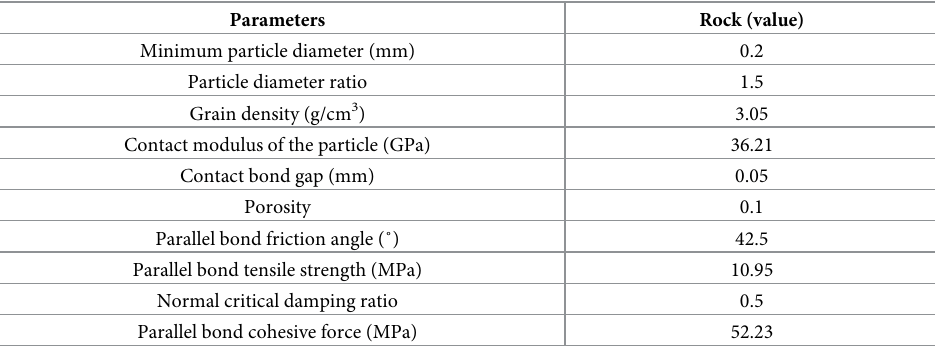
Table 1. Microscopic parameters of